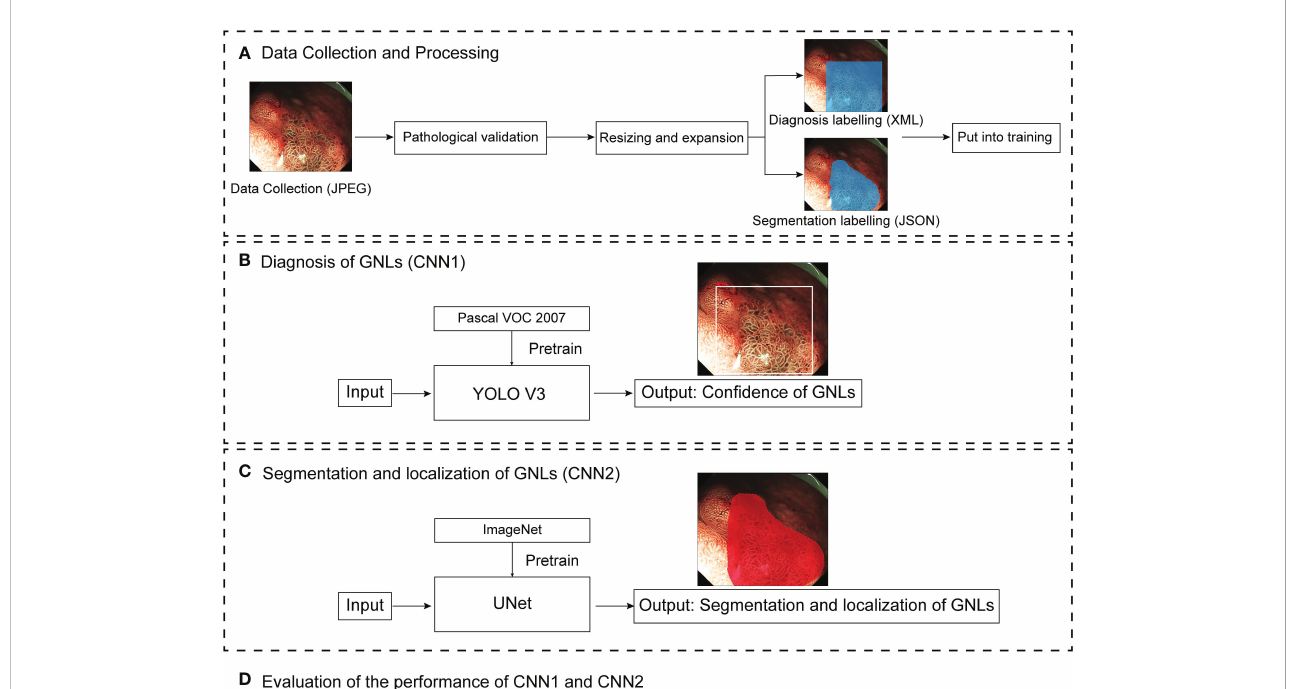
FIGURE 1 Pipeline diagram of this study. ME-NBI images were collected as JPEG fi les. After pathological validation, the images were resized and expanded, and labelled by endoscopists for training the different deep learning models. CNN1 and CNN2 are two parallel models. CNN1 output the con fi dence of GNLs and CNN2 output the segmentation and localisation of GNLs. Finally, the performance of CNN1 and CNN2 were evaluated. ME-MBI, magnifying endoscopy with narrow band imaging; CNN, convolutional neural network; GNLs, gastric neoplastic